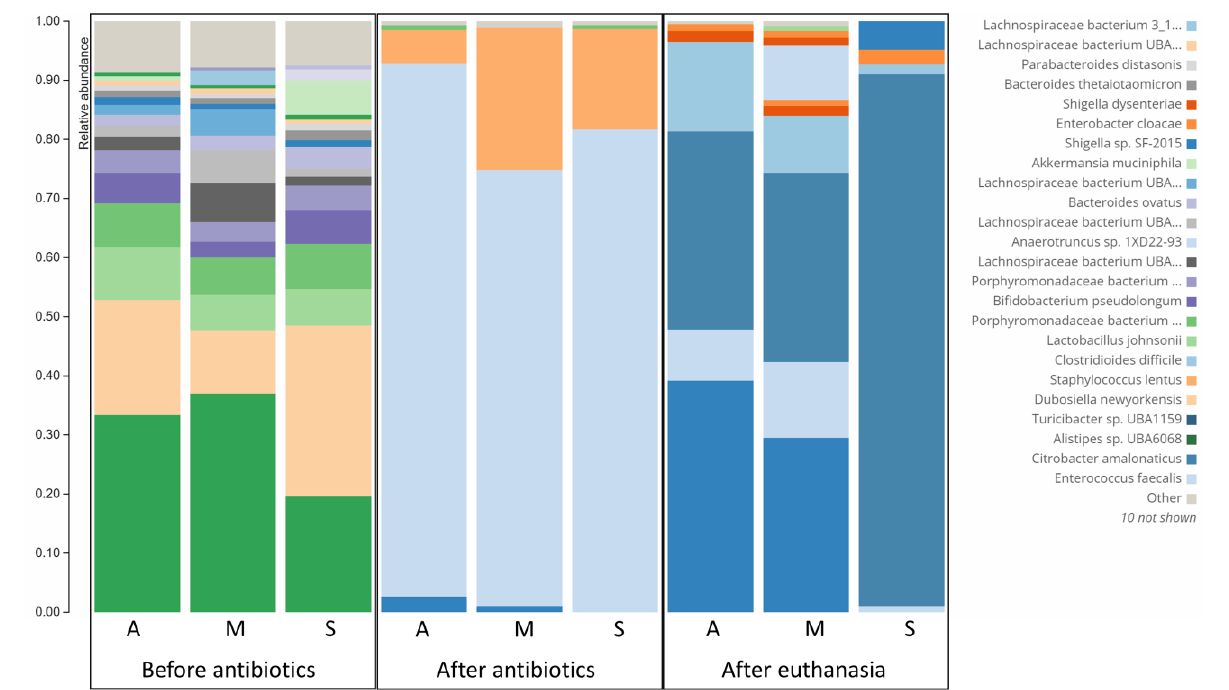
Figure 5. Microbiome analysis of asymptomatic (A), moderately symptomatic (M), and severely symptomatic (S) mice after infection with C. difficile spores. Samples were taken from each mouse at three timepoints: before antibiotic administration, after antibiotic administration and before infection, and right before euthanasia.